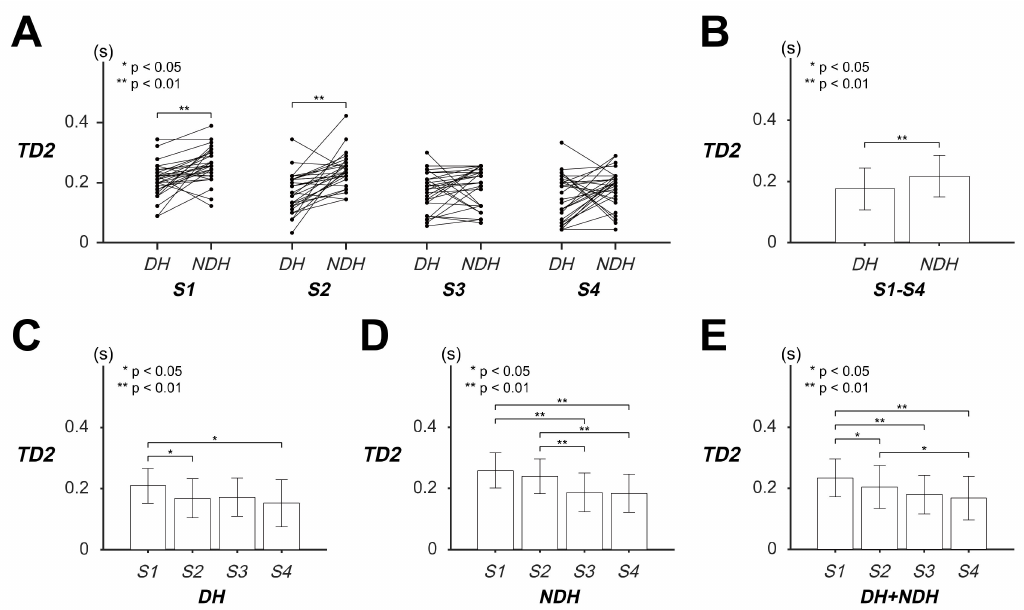
Figure 5. Evaluation of transient responses of the circular tracking movement based on the time delay (TD2) on the frontal plane. ( A ) The values of TD2 of 29 subjects at four speed factor levels. ( B ) The pairwise comparison between dominant hand (DH) and non-dominant hand (NDH) is shown for the TD2 of all speed factors. ( C ) Pairwise comparisons of TD2 are represented for each speed factor with the DH and ( D ) NDH. ( E ) Pairwise comparison of TD2 with both the DH and